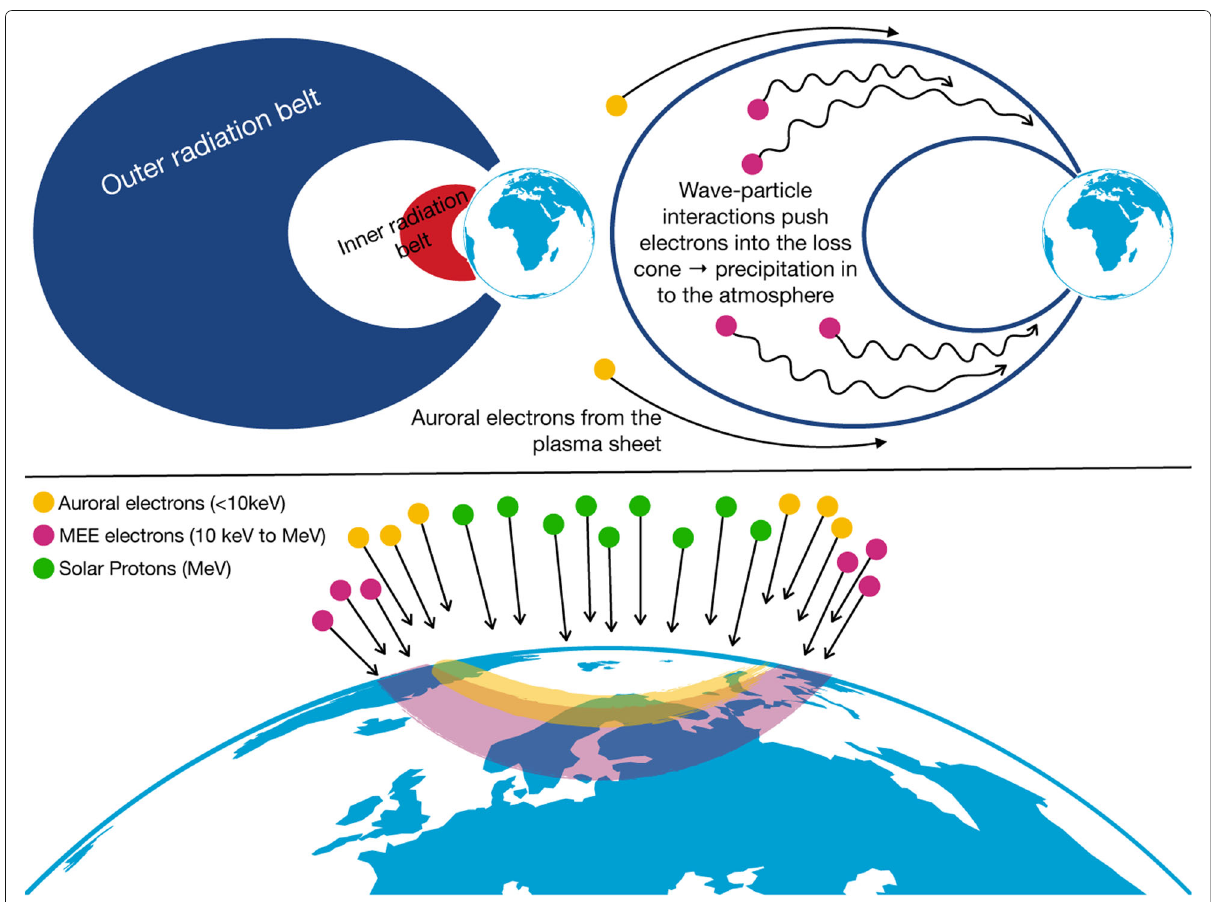
Fig. 4 Sources of EPP. The so-called medium energy electrons (MEE, > 10 keV to several MeV) originate in the Earth’s outer radiation belt, and their fluxes into the atmosphere are understood to be controlled by magnetospheric wave-particle interactions. Auroral electrons ( < 10 keV) originate primarily from the plasma sheet which is located in the tail/night side of the magnetosphere, while solar protons (not included in the top image) are injected as a result of solar storms. The map in the bottom panel illustrates that the different types of particles can influence slightly different geographic areas when they enter the atmosphere (note that locations are only indicative and are influenced by the particle energies). While the Northern Hemisphere is shown here, precipitation also occurs in the Southern Hemisphere. For detailed information, see Matthes et al.